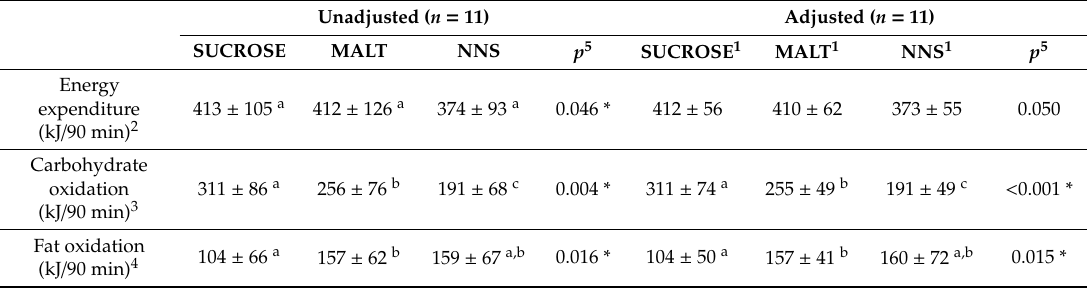
Table 1. Energy expenditure, carbohydrate and fat oxidation of 11 participants over 90 min during the indirect calorimetry measurement on SUCROSE, NNS and MALT test